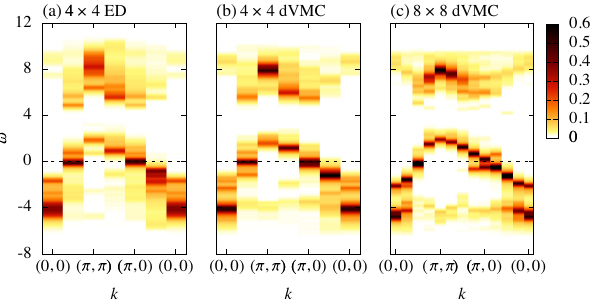
FIG. 5. Comparisonofspectralweight A ð k; ω Þ inthemomentum- energy plane for the square-lattice Hubbard model at half-filling 16 ) calculated by ED (a) and by dVMC (b). ( N ¼ 4 × 4 and N e ¼ For the 16-site dVMC calculation, we consider combinations of everypossibleneighborforthechoiceof δ and δ 0 inEq.(18).Intotal, 377 excitations are taken into account after omitting N exc ¼ redundant excitations. The result of the same quantity for the 8 × 8 lattice is shown in panel (c), which shows an essential agreement with the result of cluster perturbation theory [47,48]. In panels (a) – (c), A ð k; ω Þ is plotted along the symmetric line of the momentum in the Brillouin zone.